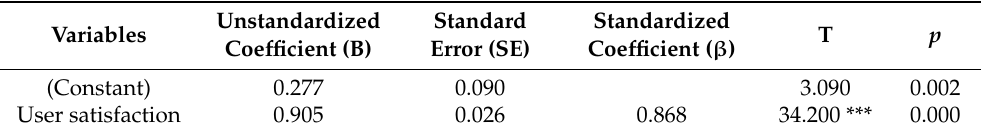
Table 11. Effect of user satisfaction on reuse